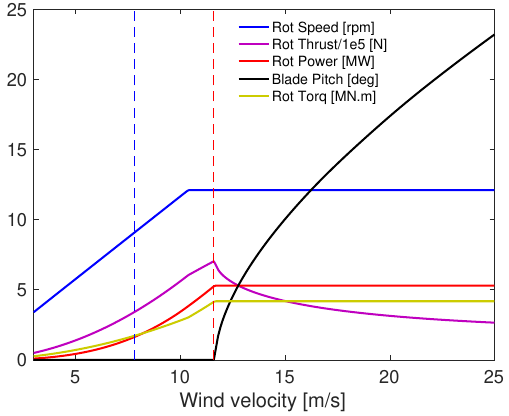
Figure 9. Wind turbine response